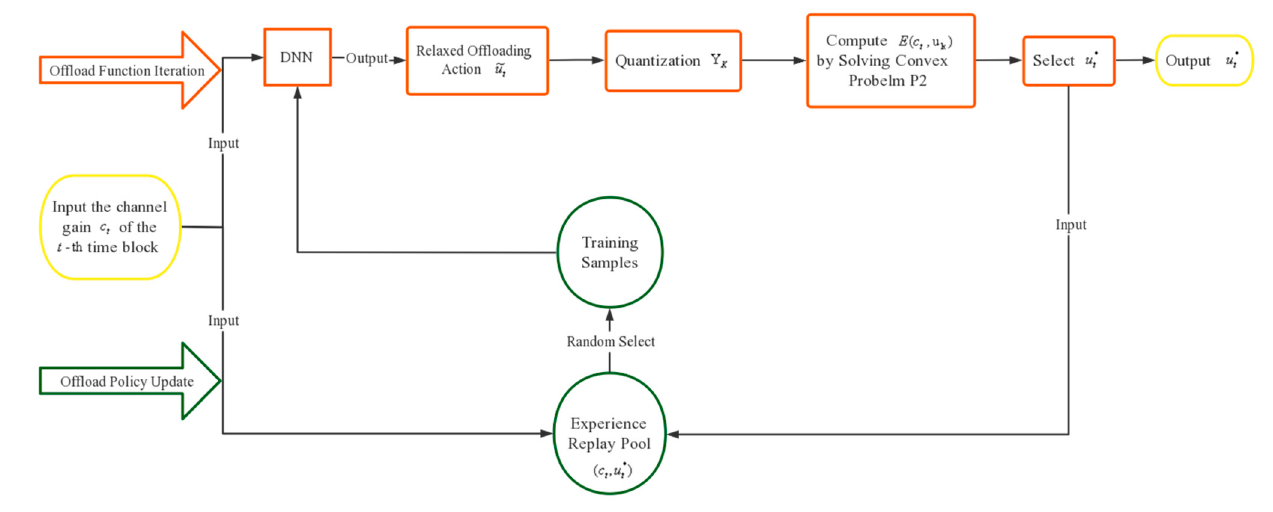
Figure 3. The structure of the DOTO algorithm.